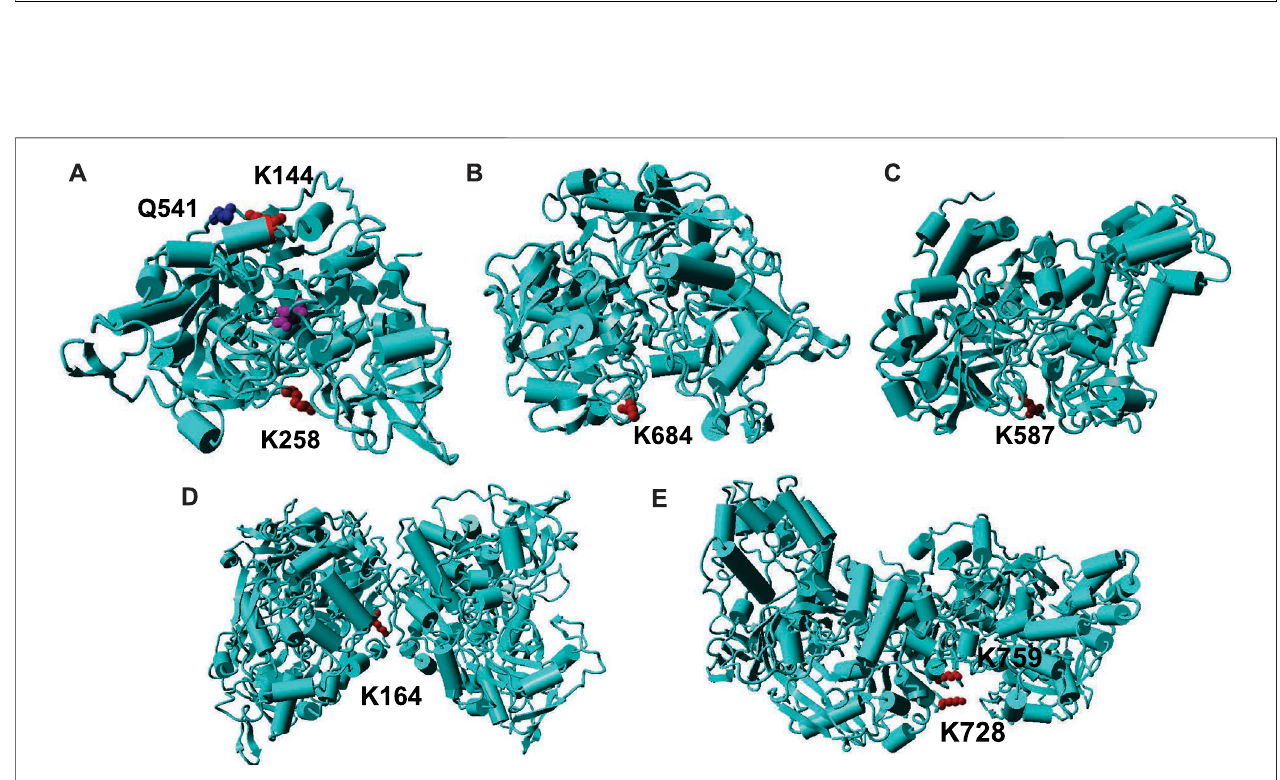
FIGURE4| Mappingofacetylatedlysineresidues onthestructuresofAcnAandAcnB. (A) ThecrystalstructureofhumancAcn(PDBID:2B3Y). (B) Thehomology modelofAcnAstructurebasedonhumancAcn. (C) ThecrystalstructureofAcnB(PDBID:1L5J). (D) ThehomologymodelofAcnAdimerbasedonhumancAcn. (E) The structure of AcnB dimer. The backbone of the protein is in cyan; lysine residues are in red; other key residues are in blue; the substrate is in purple.